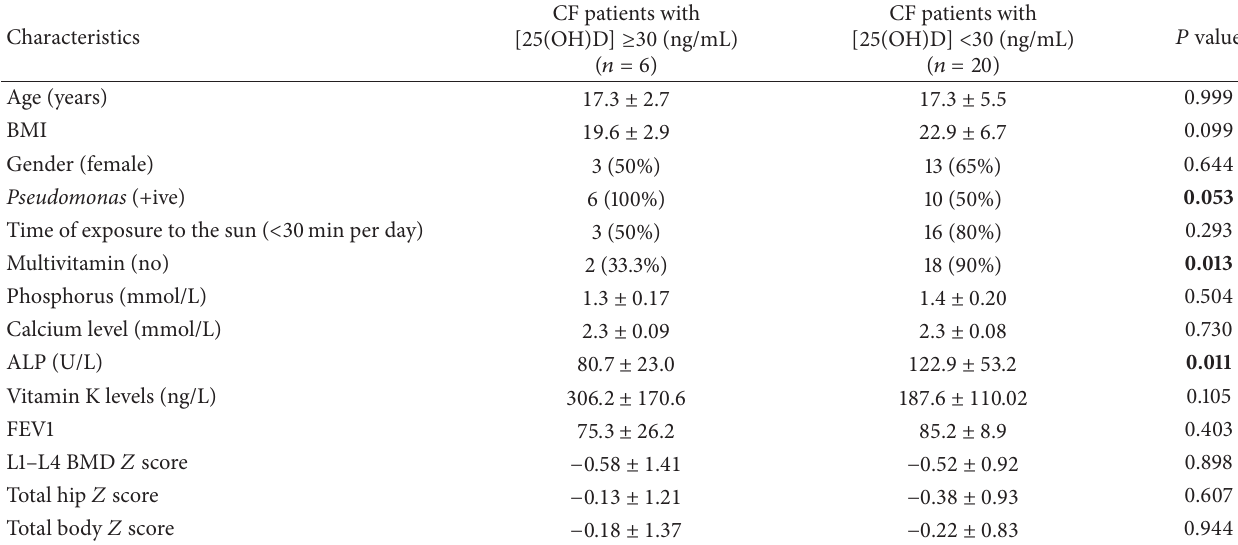
Table 2: Association of different factors between CF patients having normal and low vitamin D [ 25(OH)D ] . Characteristics